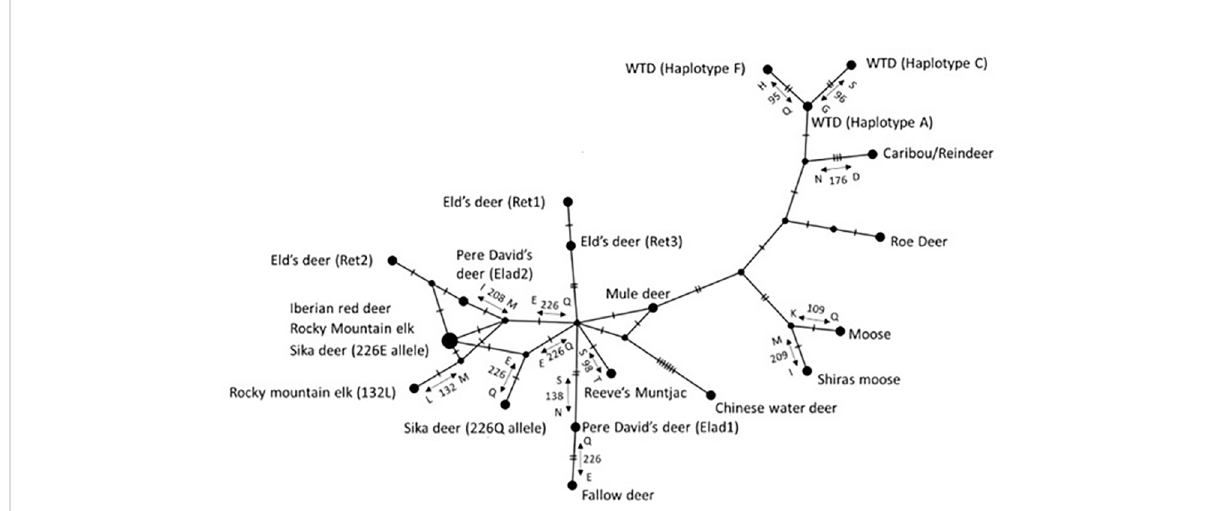
FIGURE 2 Median-joining network showing variation among PRNP sequences in cervid taxa. Each labeled circle represents a distinct haplotype and each hatch mark on the branches represents a single nucleotide substitution. For non-synonymous substitutions, the amino acid abbreviations are listed along the branches with their codon number. Eld ’ s deer haplotypes Ret1 and Ret3 group together, while haplotype Ret2 is more similar to sequences from other cervids than to haplotypes Ret1 and Ret3. WTD is the abbreviation for white-tailed deer. From three of the species shown, identical PRNP sequences have been reported: Iberian red deer (KT845864), sika deer (those with the 226E substitution; AY679695), and Rocky Mountain elk (EU082291). The node that represents the PRNP sequence from these three species is drawn larger than the nodes that represent the PRNP sequence from a single